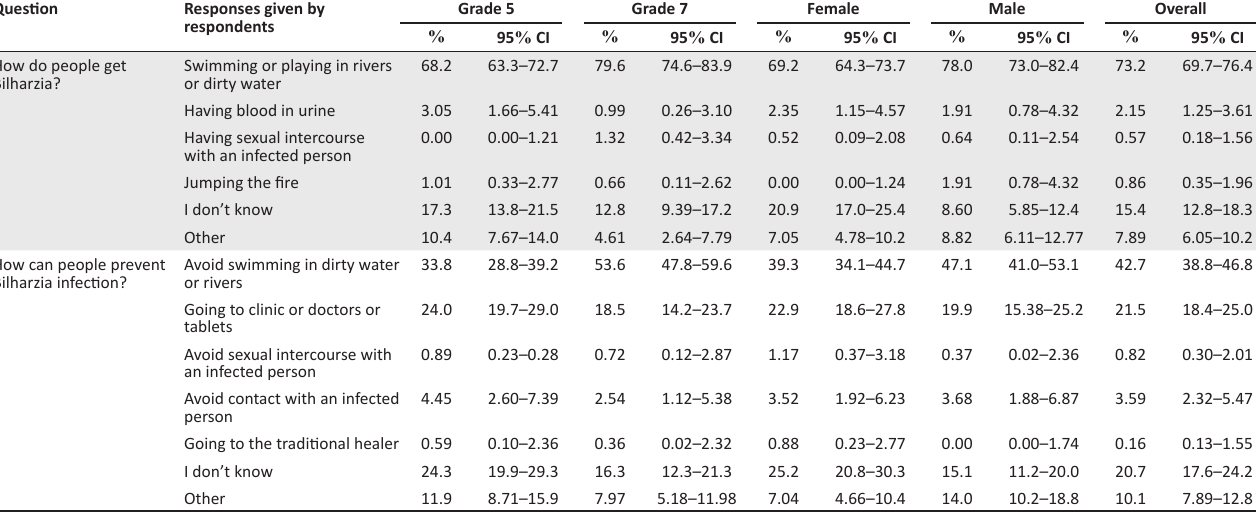
TABLE 1: Learners’ responses to questions on infection and prevention of schistosomiasis by grade, sex and district. Question Responses given by respondents